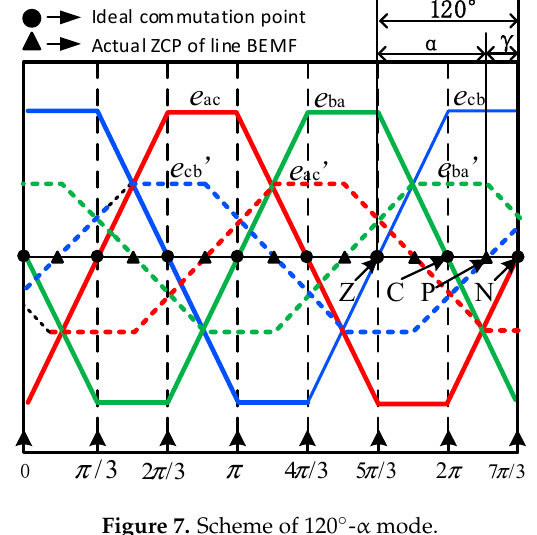
Figure 7. Scheme of 120°- α mode.